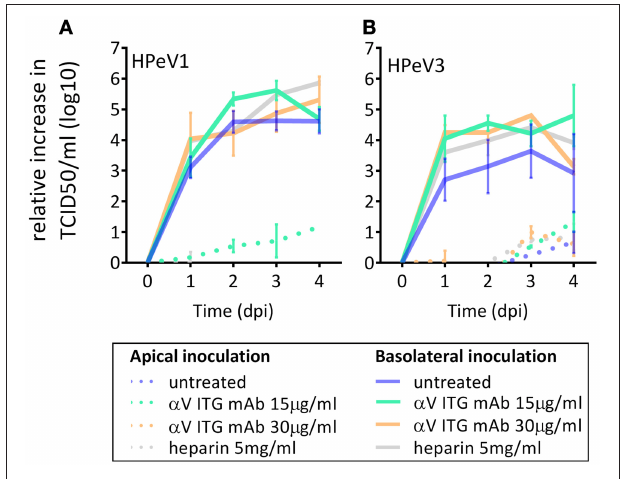
FIGURE 3 | Effect of α V ITG and HS blocking on HPeV replication. Relative increase in HPeV1 (A) and HPeV3 (B) 50% tissue culture infectious dose (TCID50) titers in apical samples following function blocking ITG α V mAb pretreatment (15 µ g/ml or 30 µ g/ml) of the HAE cultures or heparin pretreatment (5 mg/ml) of the virus inoculum. Mean and standard error of mean for three biological replicates is shown. Basolateral sampling data not